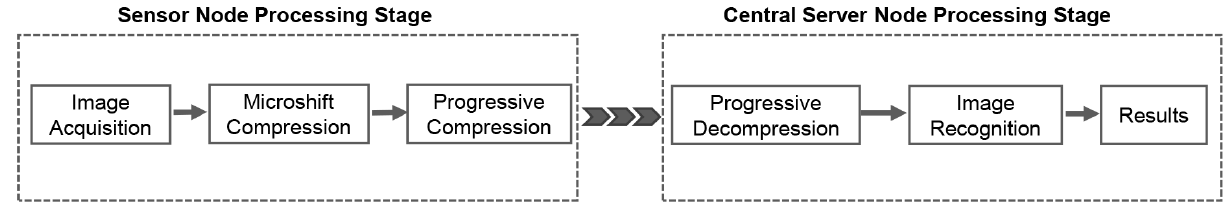
Figure 2. Proposed wireless vision sensor network